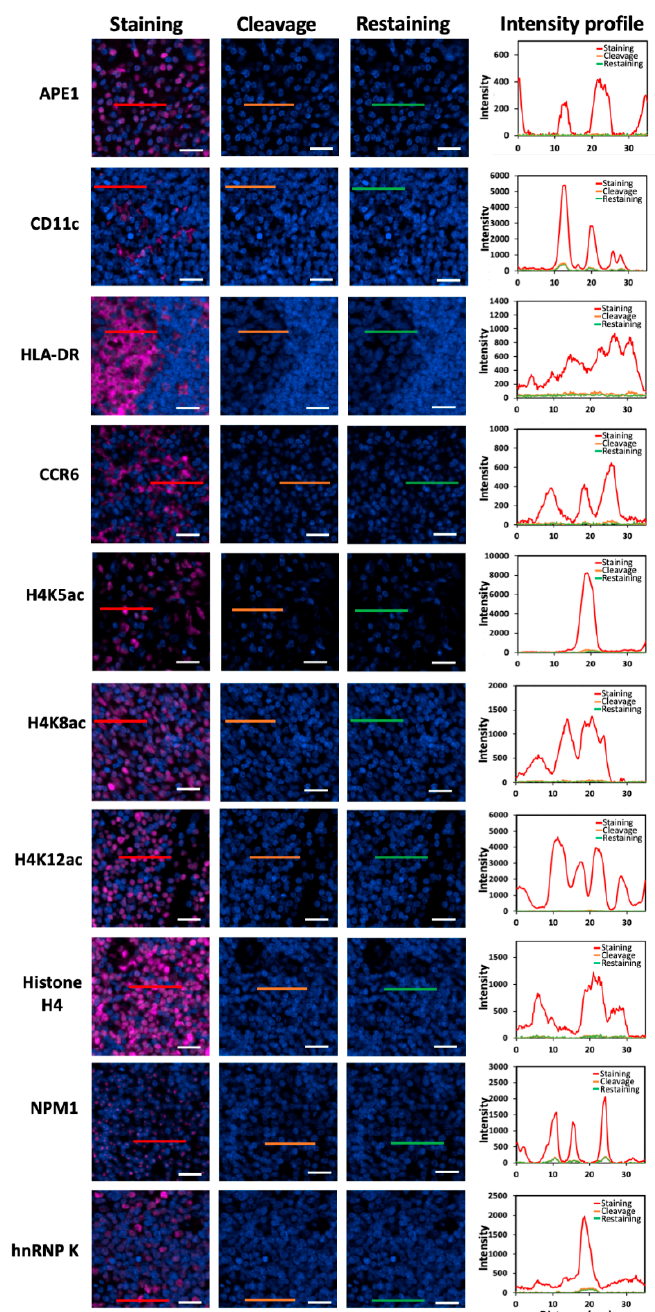
Figure 2. Different proteins are stained with HRP-conjugated antibodies and CFT in FFPE tonsil tissues (the first column). Then, the staining signals are erased by PTA and TCEP (the second column). After antibody stripping, the tissues are re-incubated with HRP-conjugated secondary antibodies and CFT (the third column). The fourth column displays the fluorescence intensity profiles corresponding to the red, orange and green line positions in the first three columns. Scale bars, 20 μ m.